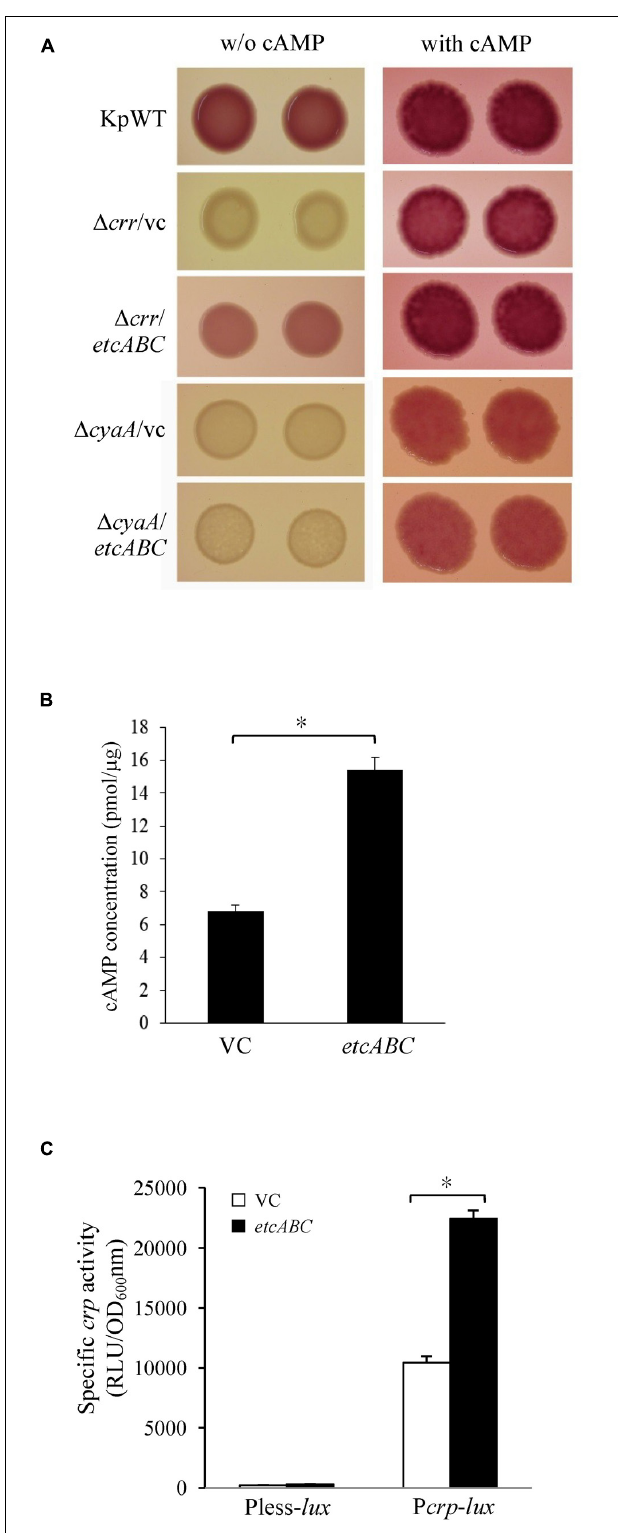
FIGURE 5 | The effects of etcABC on cAMP production. (A) The representative colony morphology of K. pneumoniae STU1 and its derivative